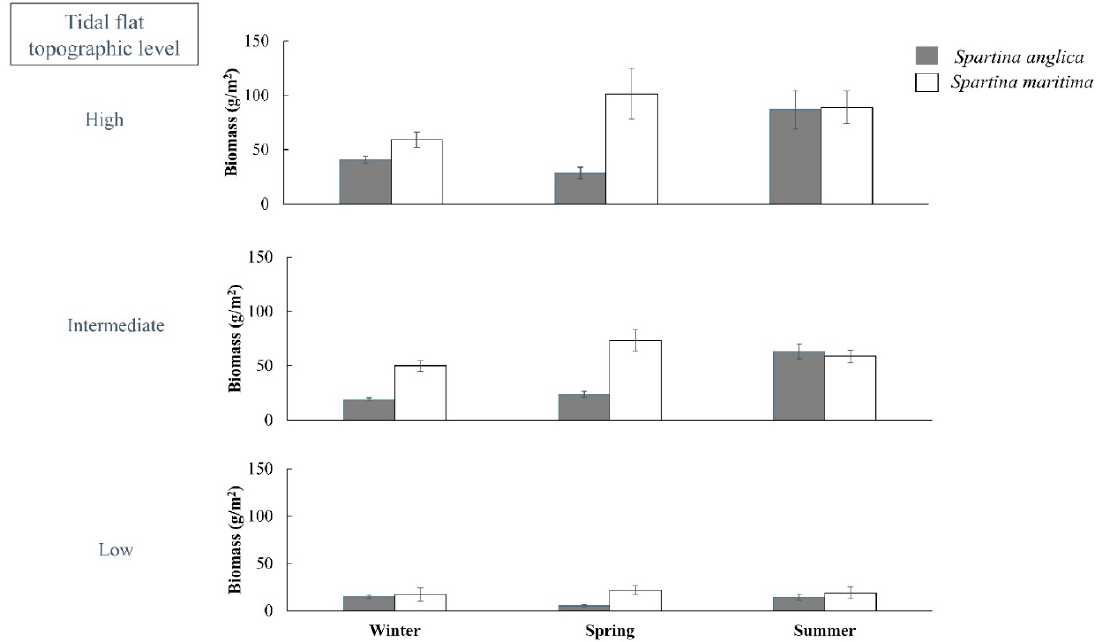
Figure A1. Seasonal biomass (winter, spring and summer) of Spartina anglica (dark bars) and Spartina maritima (white bars) at three tidal flat relative topographic levels.